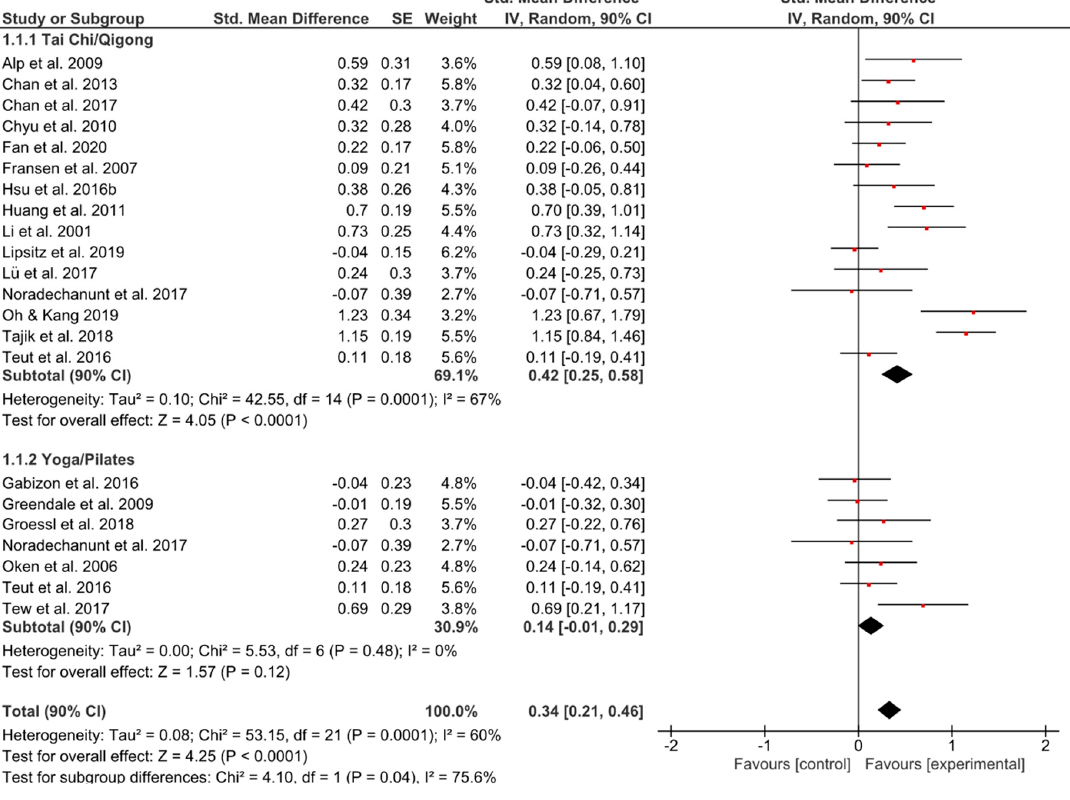
Figure 2. Standardized mean effects of mind–body interventions on quality of life compared to a non-exercise control group. Data are separately presented for Tai Chi / Qigong and Yoga / Pilates. SE: standard error; IV: inverse variance model; CI: confidence interval; Std.: standardized.